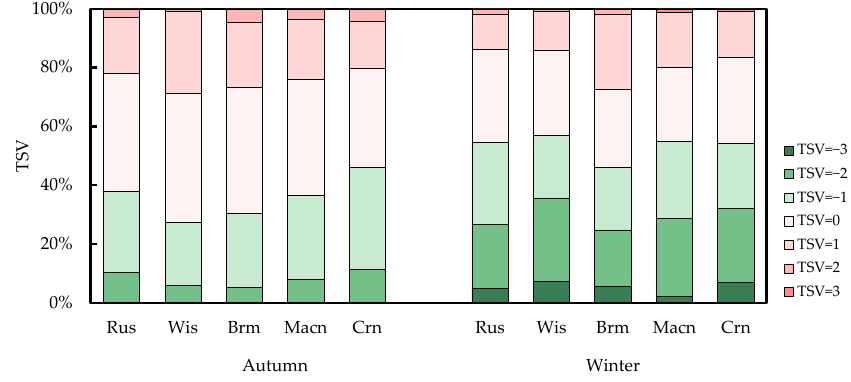
Figure 6. Distribution of the TSV among sound types.